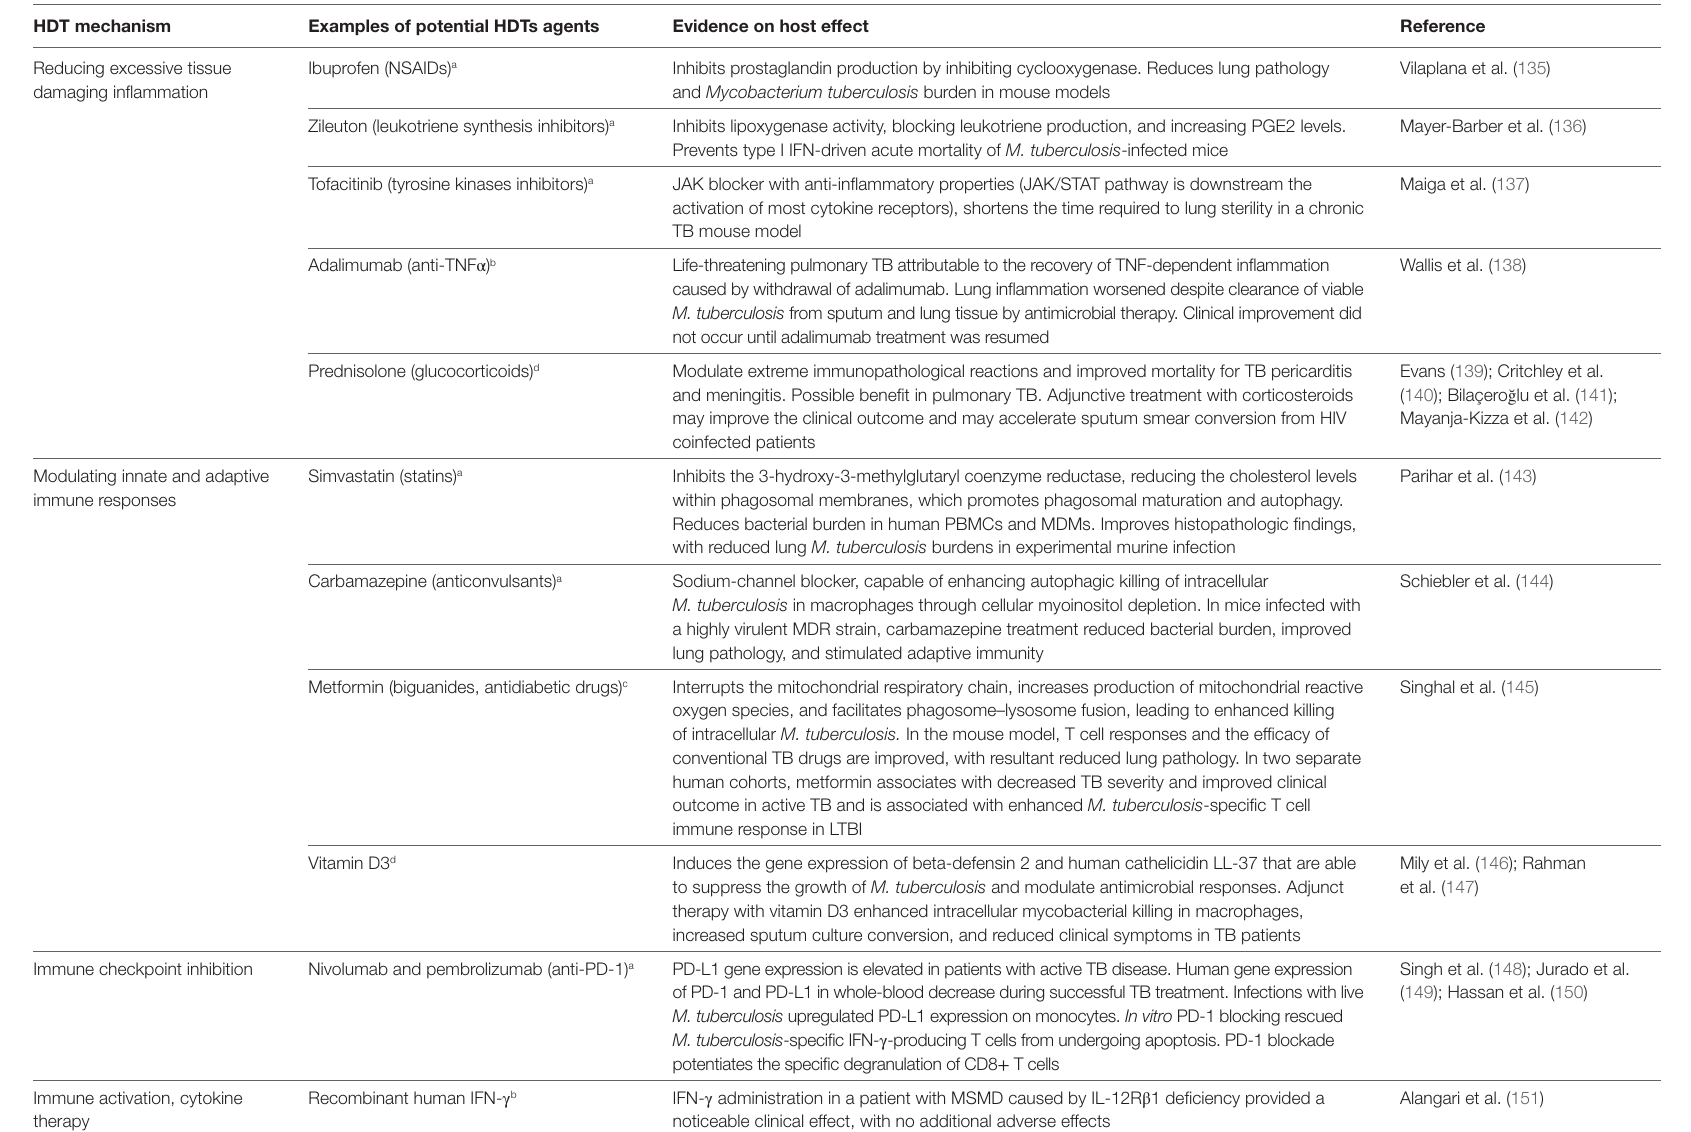
TABLe 1 | Evidence supporting HDTs for